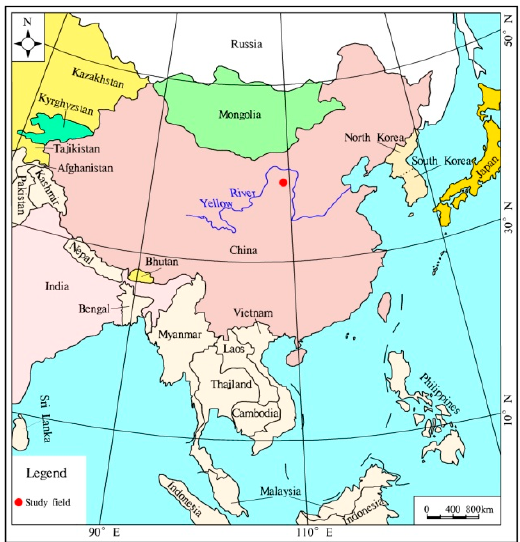
Figure 1. Location map of the field study.